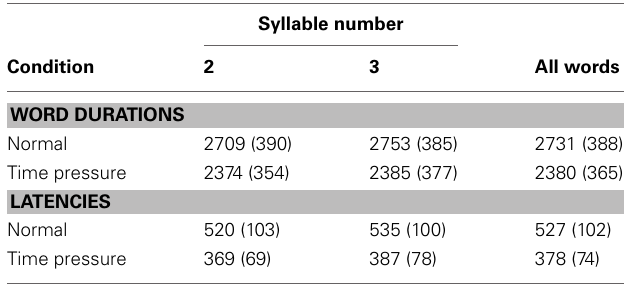
Table 1 | Mean word durations (standard deviations) and mean latencies (standard deviations) in ms as a function of writing condition and syllable number.